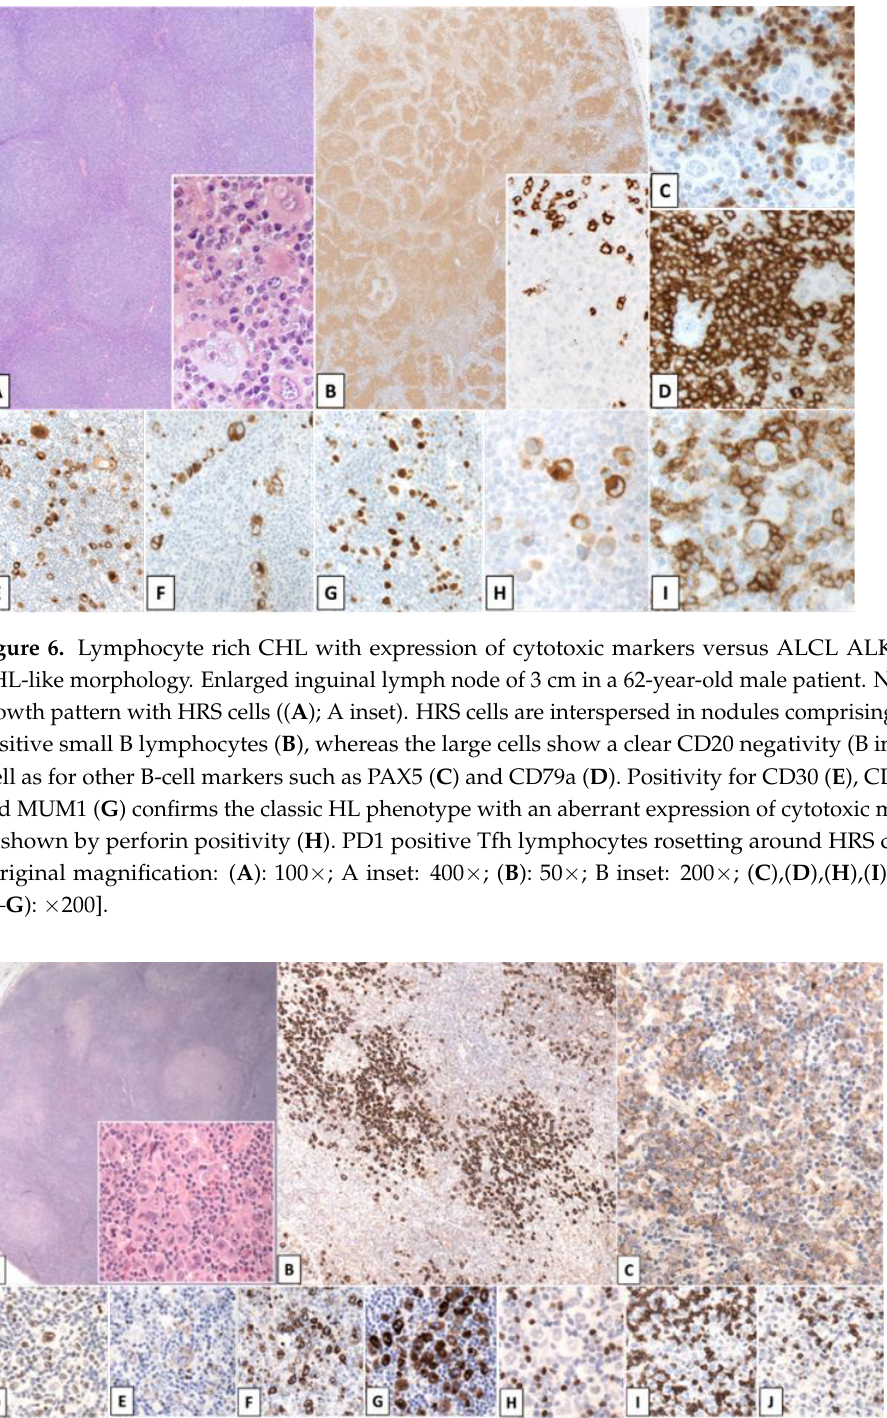
Figure 7. Cytotoxic Peripheral T-cell lymphoma NOS simulating CHL. Massive left-sided axillary lymphadenopathy in a 65-year-old male patient. Polymorphous infiltrate with nodular growth pattern ( A ) comprising prominent HRS-like cells (A inset). Positivity for CD30 ( B ), CD15 ( C ), MUM1 ( D ), TIA1 ( E ), Granzyme B ( F ) and Perforin ( G ). Clear negativity for PAX5 ( H ), CD3 ( I ) and CD8 ( J ). Molecular studies demonstrated a clonal TCR- γ rearrangement. [Original magnification: A: 50×; A inset: ×400; B: 100×; C – J: ×200].